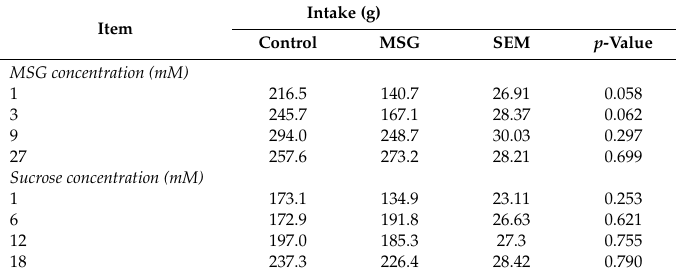
Table 5. Pigs total consumption of di ff erent concentrations of MSG and sucrose solutions in animals born from control and MSG-fed sows 1 .